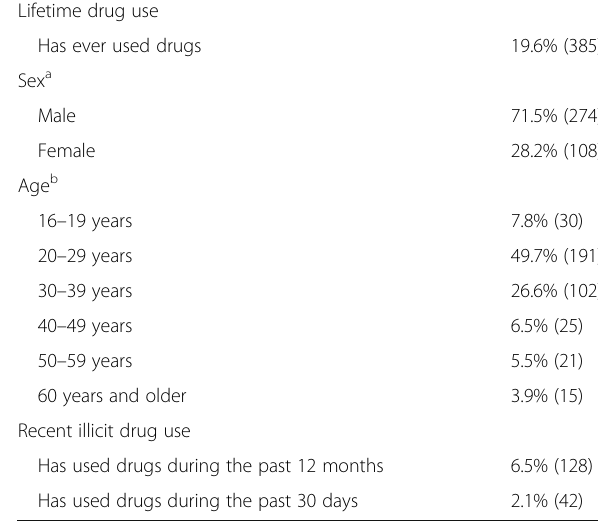
Table 1 Sample characteristics of gym-goers ( n = 1969) Table 2 Lifetime drug use among gym-goers ( n =